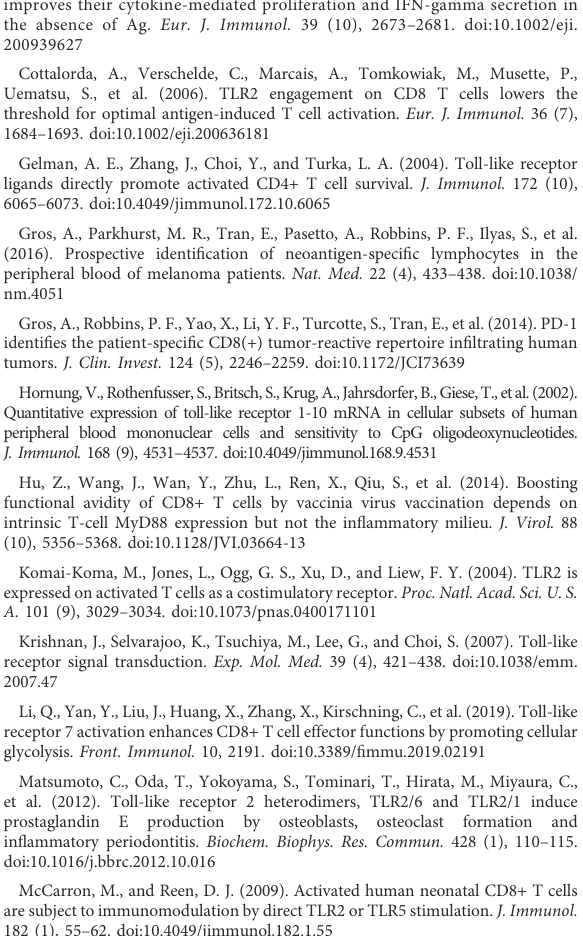
SUPPLEMENTARY FIGURE S3 Measurements of cytokine release by expanded CD8 + T cells. The levels of indicated cytokines in the culture medium of expanded CD8 + T cells were assessed by ELISA. Related to Figure 4. SUPPLEMENTARY FIGURE S4 TLR agonists exposure during ex vivo expansion had little effect on the cell killing capability of the expanded PD1+ CD8 + cells. Shown is the result of a representative experiment in which cell products expanded